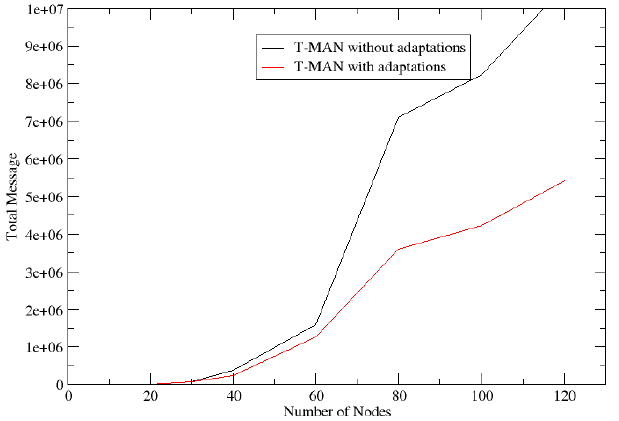
Figure 7. Total messages for overlay topology formulation.